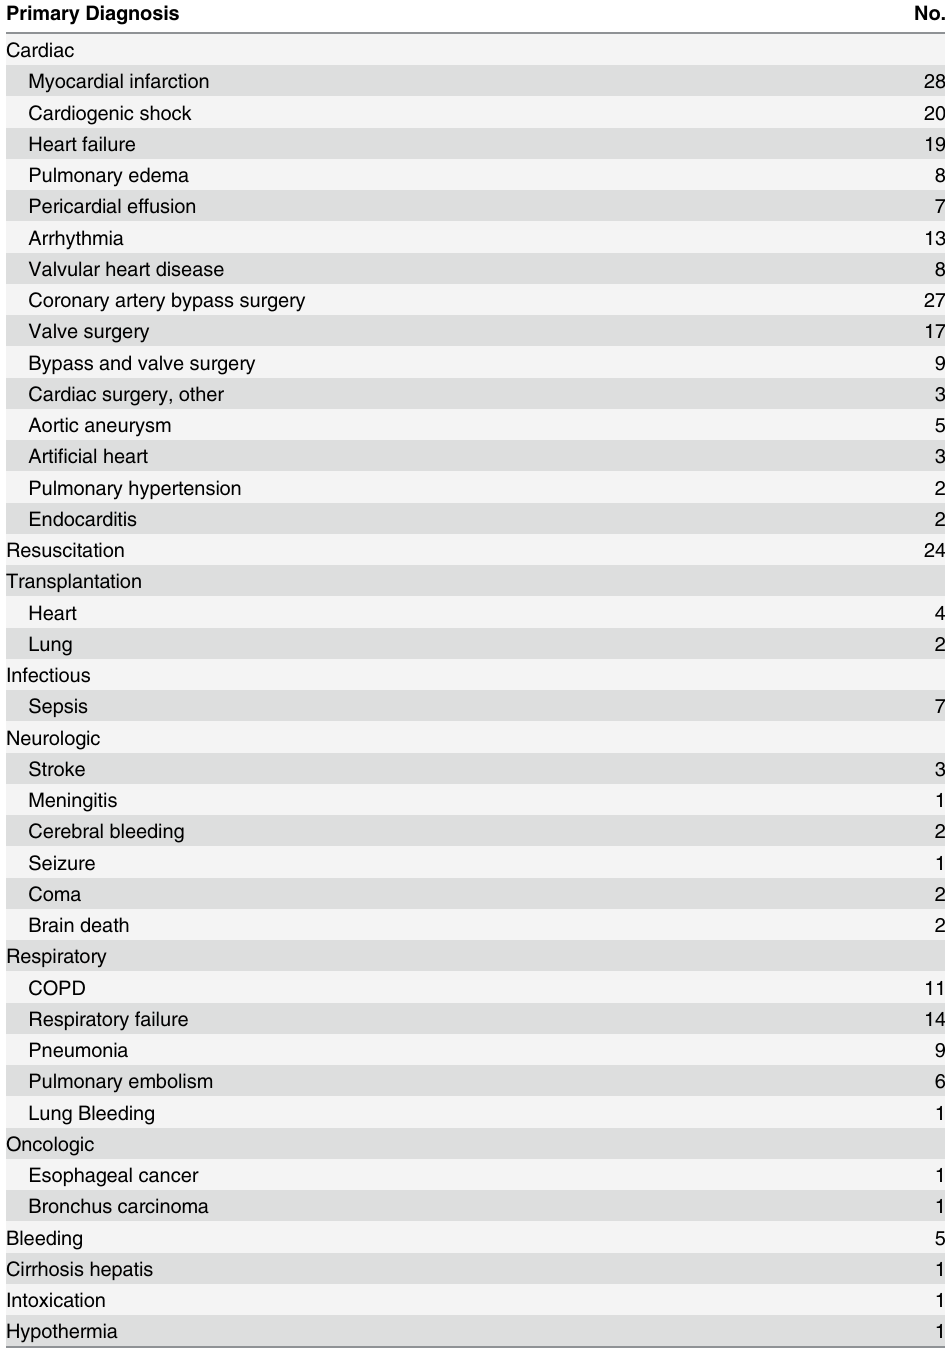
Table 1. Primary